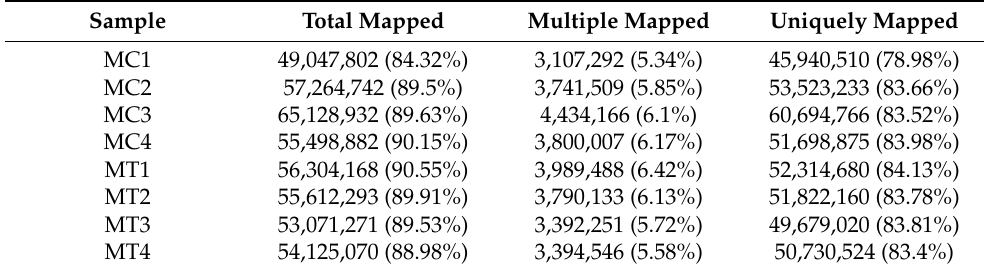
Table 2. Gene comparison analysis after quality control.